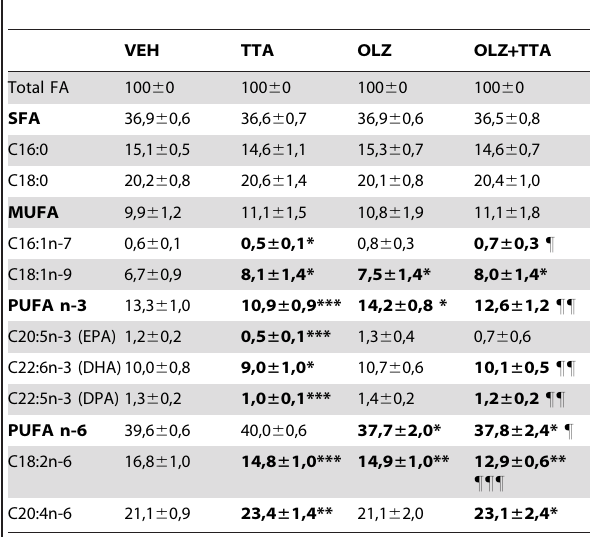
Data are given in % of total fatty acid content, and presented as mean% 6 SEM. * P # 0.05 vs vehicle.